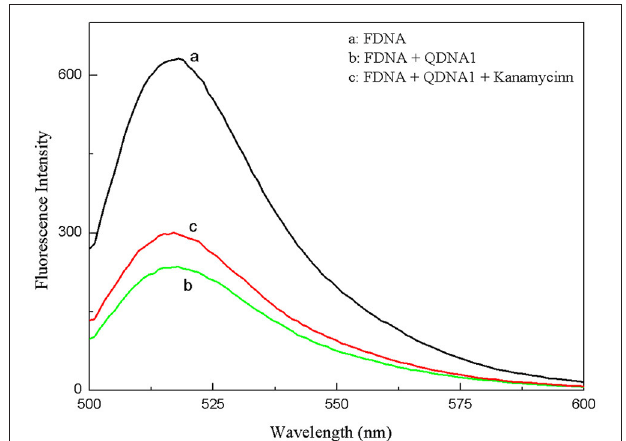
FIGURE 1 | Overlap between the fluorescence emission spectrum of FAM fluorophore (a) and the absorption spectrum of Dabcyl quencher (b).